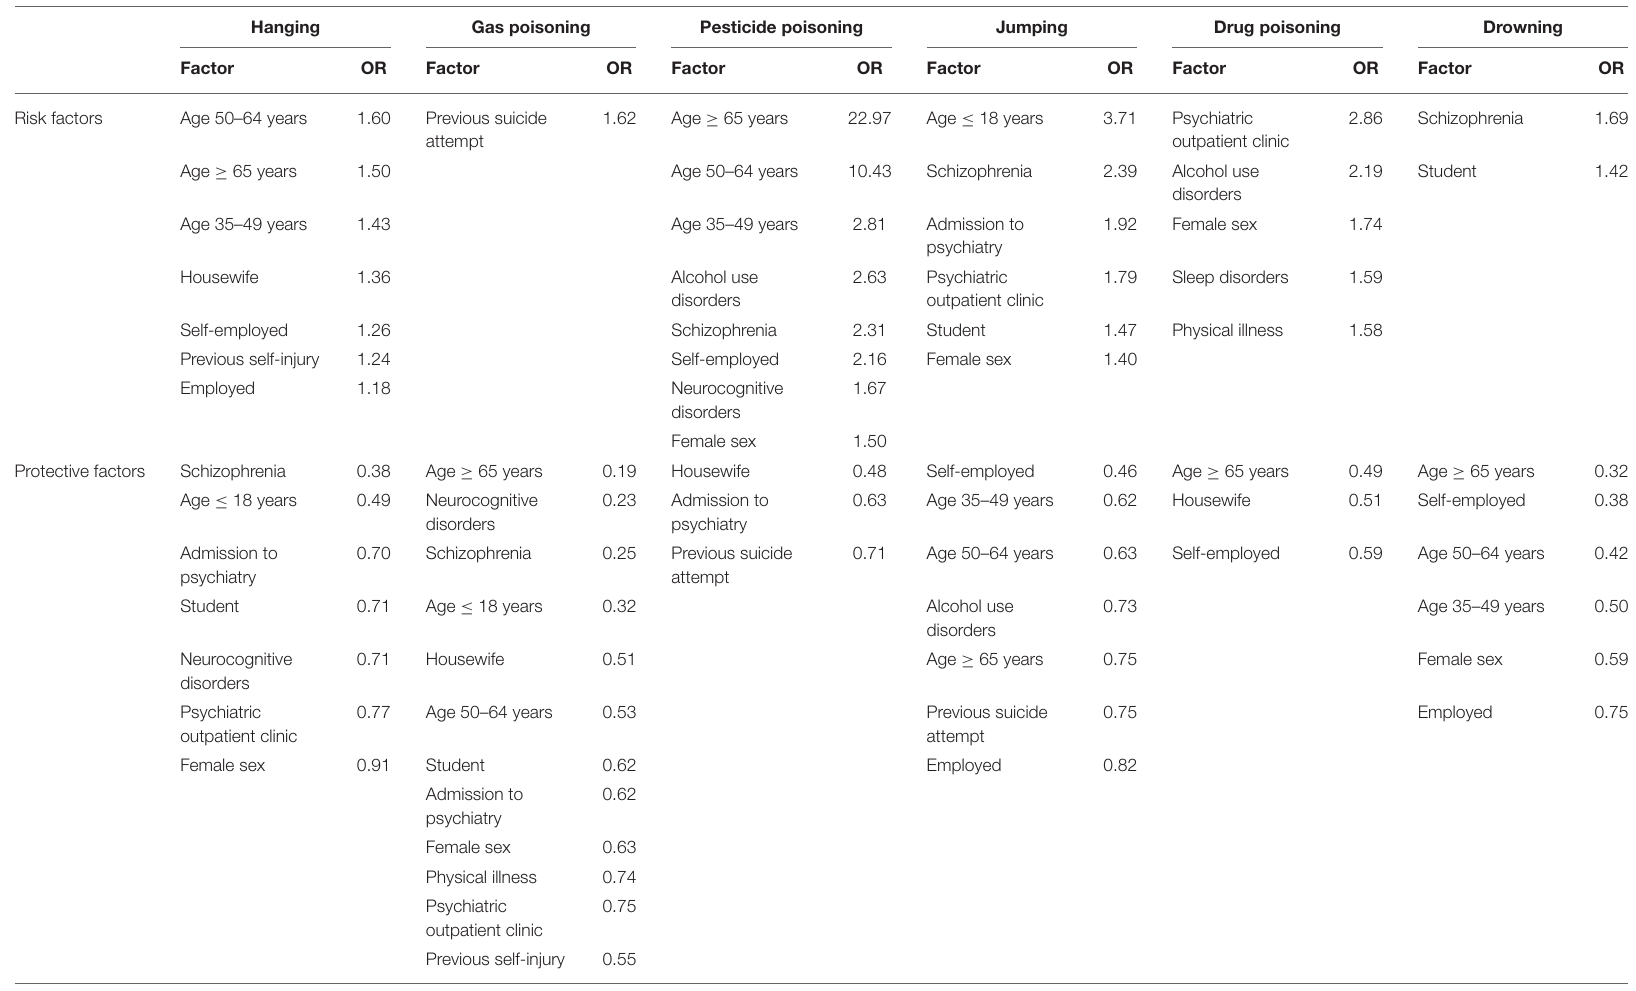
TABLE 4 | Risk factors and protective factors for each method of suicide based on multivariate logistic regression a . Hanging Gas poisoning Pesticide poisoning Jumping Drug poisoning Drowning Factor OR Factor OR Factor OR Factor OR